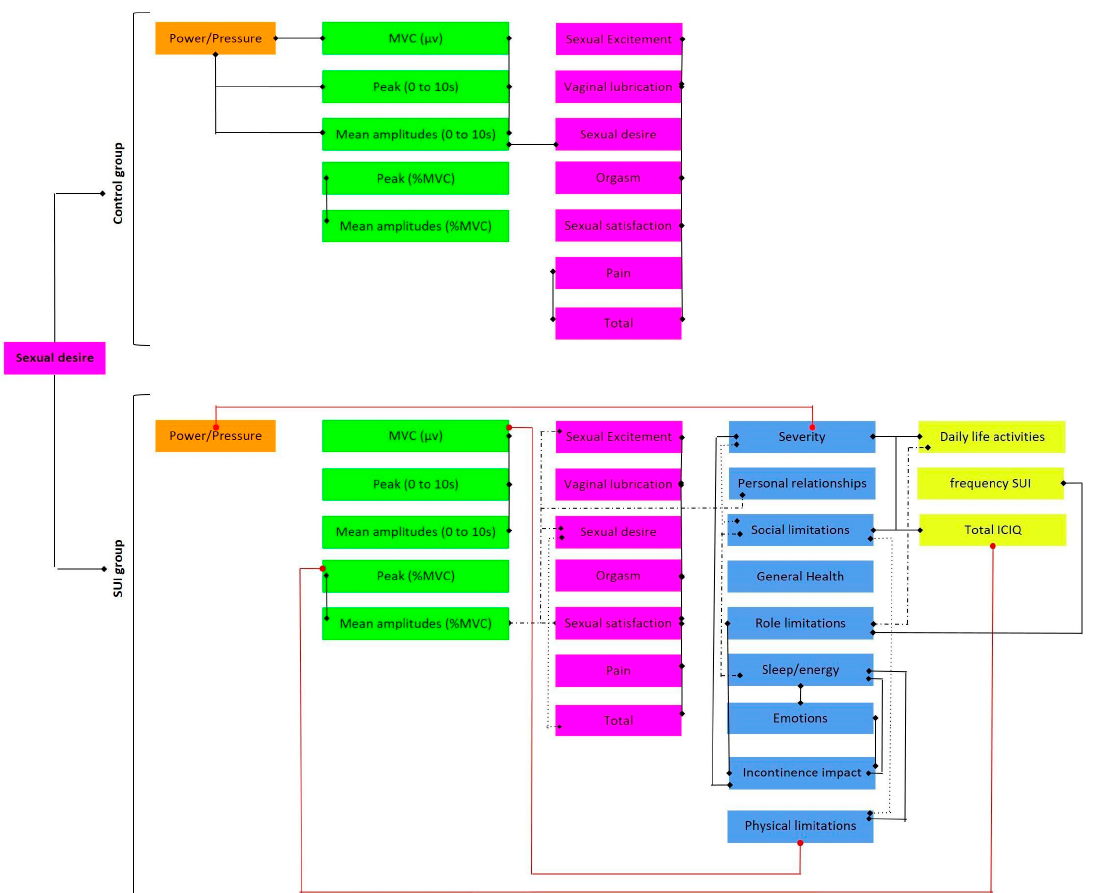
Figure 1. Schematic of results showing significant correlations in the control and SUI groups. Black lines represent positive correlations. Red lines represent negative correlations. Purple box: FSFI; Orange box: Power (pressure); Green box: sEMG; Blue box: KHQ; Yellow box: ICIQ. Table 1. Level of strength and bioelectrical activity of the pelvic floor muscles and sexual function in women with stress urinary incontinence (G2) in relation to the control group